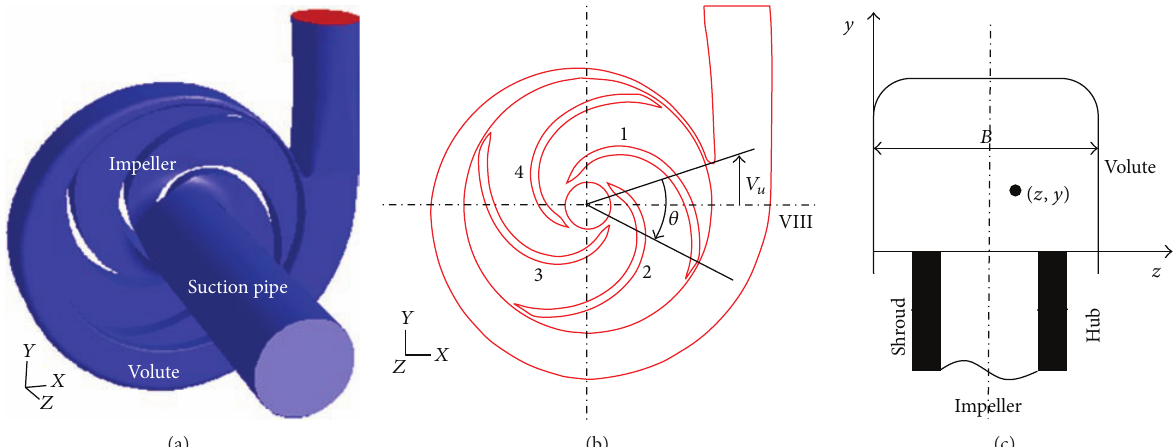
Figure 1: Fluid domain of the model pump (a), the relative position between blade 1 and the volute tongue (b), and a local coordinate system in cross-section VIII (c).